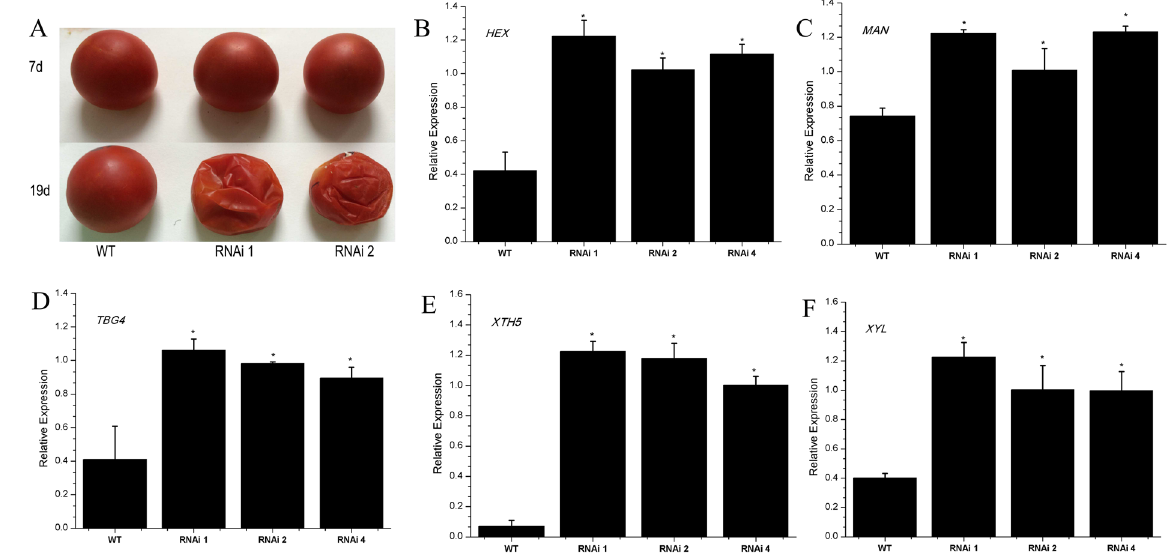
Figure 7. Phenotype and related genes expression of wild type and SlHDA1 RNAi fruits. ( A ) Fruits storability phenotype of wild type and transgenic lines. 7 d and 19 d, post-harvest storage time. ( B ) to ( F ) Relative expression profiles of related genes in the pericarp between wild type (WT) and SlHDA1 RNAi fruits. Three biological replications and three technical replications for each sample were performed. Data are the means ± SD of three independent experiments. The asterisks indicate statistically significant differences between the WT and transgenic fruits (P <